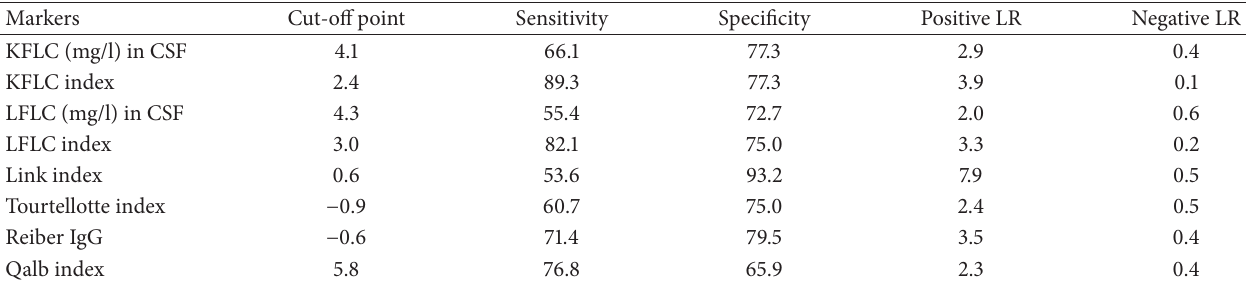
Table 3: Diagnostic accuracy of free light chain (a) and CSF standard indices (b) in multiple sclerosis (MS) and clinically isolated syndrome suggestive of MS diagnosis.